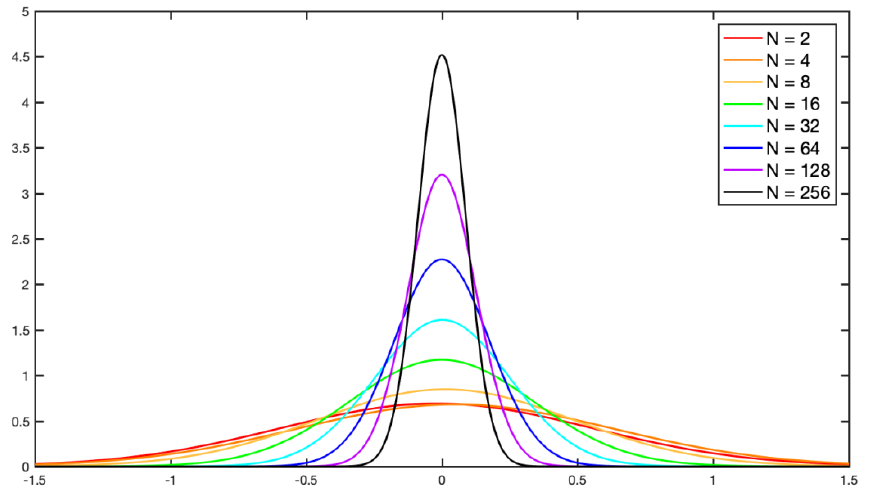
Figure 2. Probability density function of the Gram Matrix’s off-diagonal elements: the dimension N of the Gram matrix is from 2 to 256.